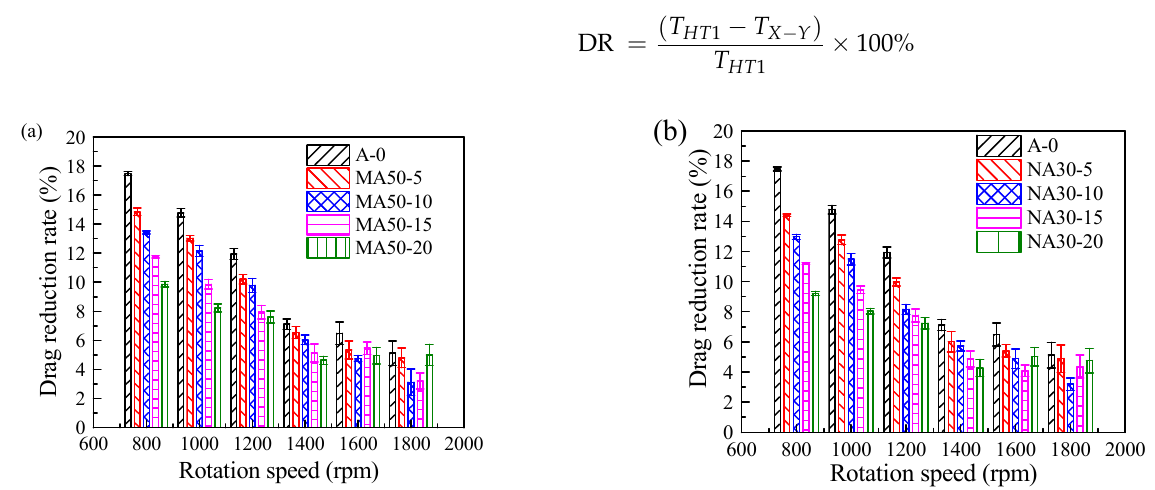
torque device. The torque (T) value represents the resistance to the rotation of the coatings in sea water. The greater the torque value, the greater the resistance. The relationship be- tween the addition and particle size of alumina and the drag reduction rate (DR) is shown torque of the test coating 𝑋 − 𝑌. in Figure 11. Epoxy paint HT 1 was chosen as the comparative coatings. This is the drag drag reduction rate Formula (1). Where T HT 1 is the torque of comparative sample, T X − Y is reduction rate Formula (1). Where T HT 1 is the torque of comparative sample, 𝑇 (cid:3025)(cid:2879)(cid:3026) is the the torque of the test coating X − Y . torque of the test coating 𝑋 − 𝑌.